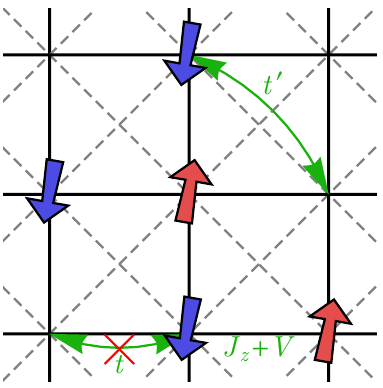
Figure 1: A depiction of the t (cid:48) - J - V model [ Eq. (1) ] that we study. This model z includes a next-nearest-neighbor hopping t (cid:48) across the dashed gray links instead of a nearest-neighbor hopping t across the solid black links. The model also includes an antiferromagnetic Ising interaction J and nearest-neighbor repulsion V across each z solid black link. Unlike a nearest-neighbor hopping t , the next-nearest-neighbor hopping t (cid:48) does not frustrate the antiferromagnetic interaction. The red and blue arrows denote spin up and spin down